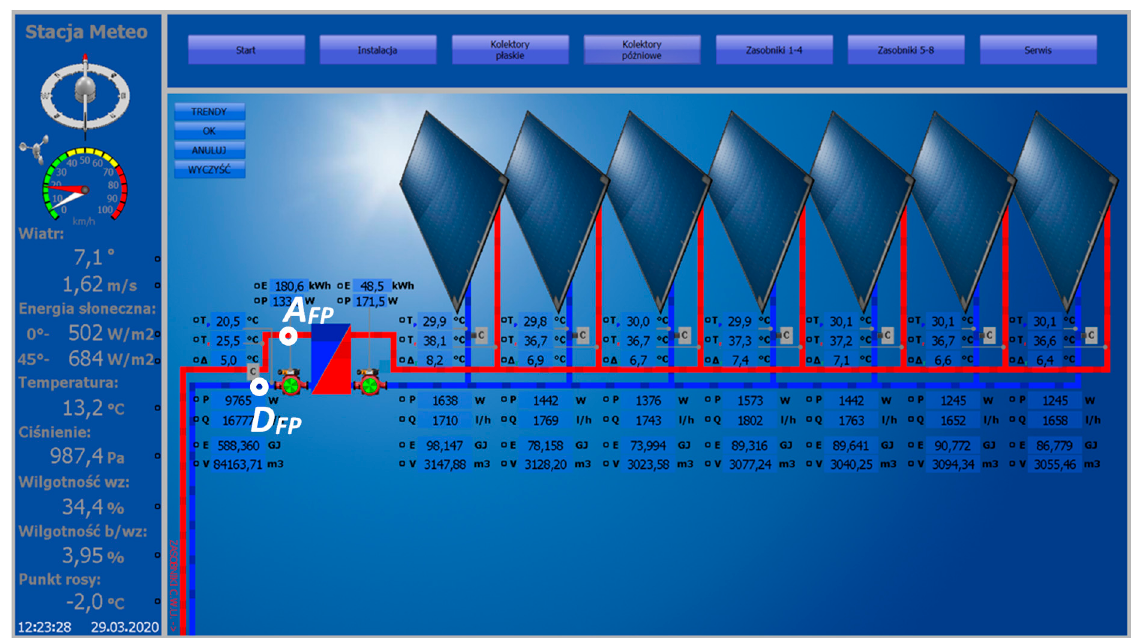
Figure 6. Screenshot of the monitoring system—loop of flat plate solar collectors.